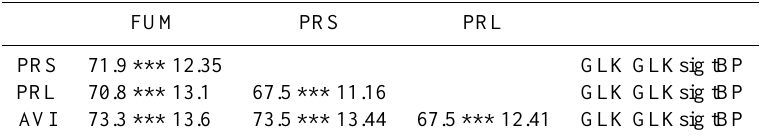
Table 3. Statistical characteristics of the AdaPres RCS chronology. First Last Length